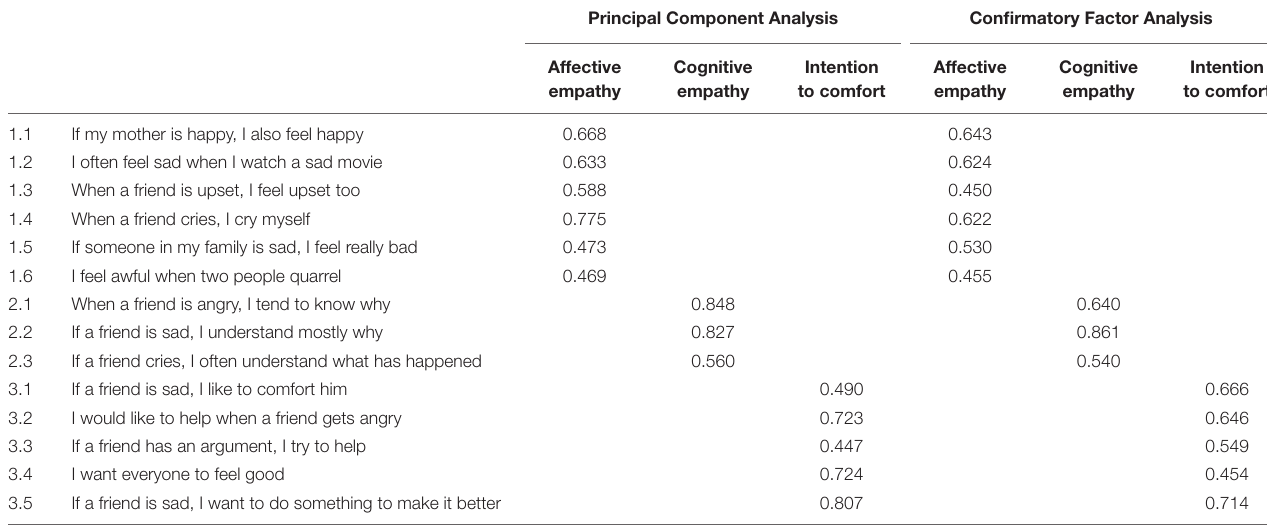
TABLE 4 | Factor Loadings for the Principal Component Analysis and the Confirmatory Factor Analysis with the three factor model of the Empathy Questionnaire for Children and Adolescents (EmQue-CA).